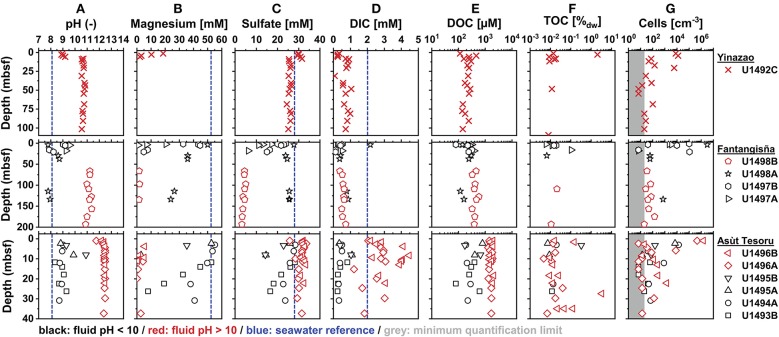
Depth profiles of (A) pH, (B) magnesium (Mg2+), (C) sulfate, (D) DIC, (E) DOC, (F) TOC, and (G) cell counts ordered in ascending distance to the Mariana Trench (top to bottom). All pH data, and magnesium (Mg2+), sulfate, DIC, and DOC concentrations were measured shipboard and were obtained from Fryer et al. (2018b). TOC (% sample dry weight) and cell abundances are from this study (gray area indicates counts that are below the quantification limit of 20 cells cm−3). Blue marks on the x-axis indicate seawater concentrations from Mottl et al. (2003). Red symbols indicate high-pH holes, black symbols indicate moderate-pH holes (see text for definitions).